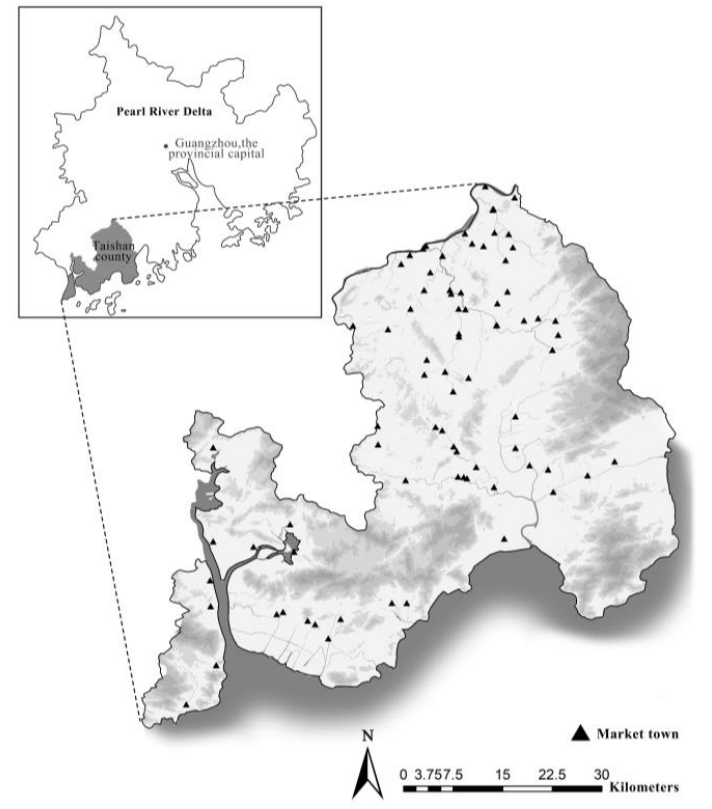
Figure 1. Geographical location of Taishan County in the Pearl River Delta Region of Guangdong Province.